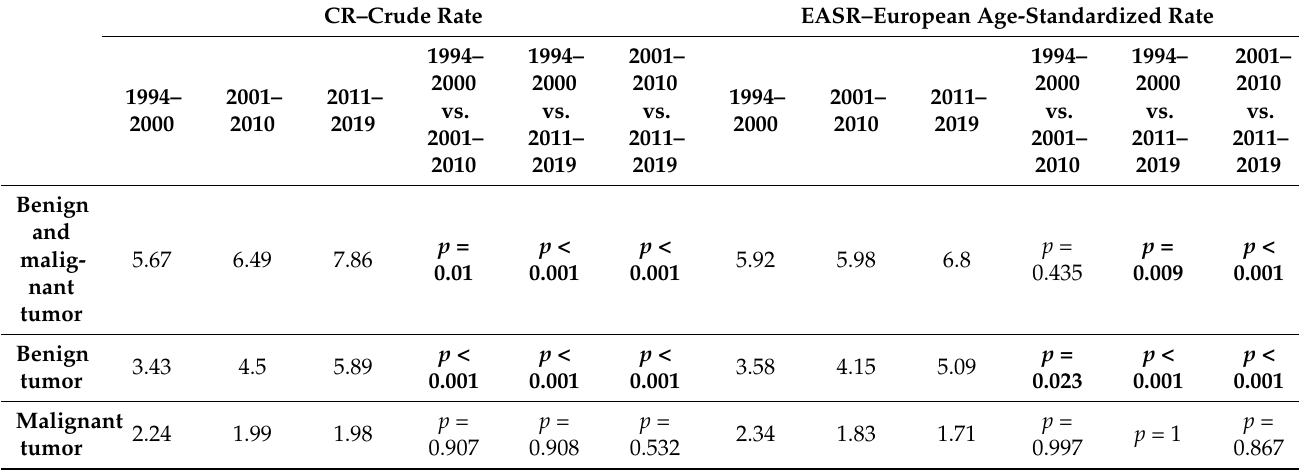
Table 7. Crude and European age-standardized incidence rates (per 100,000) for salivary gland tumors characteristics by time period in southern